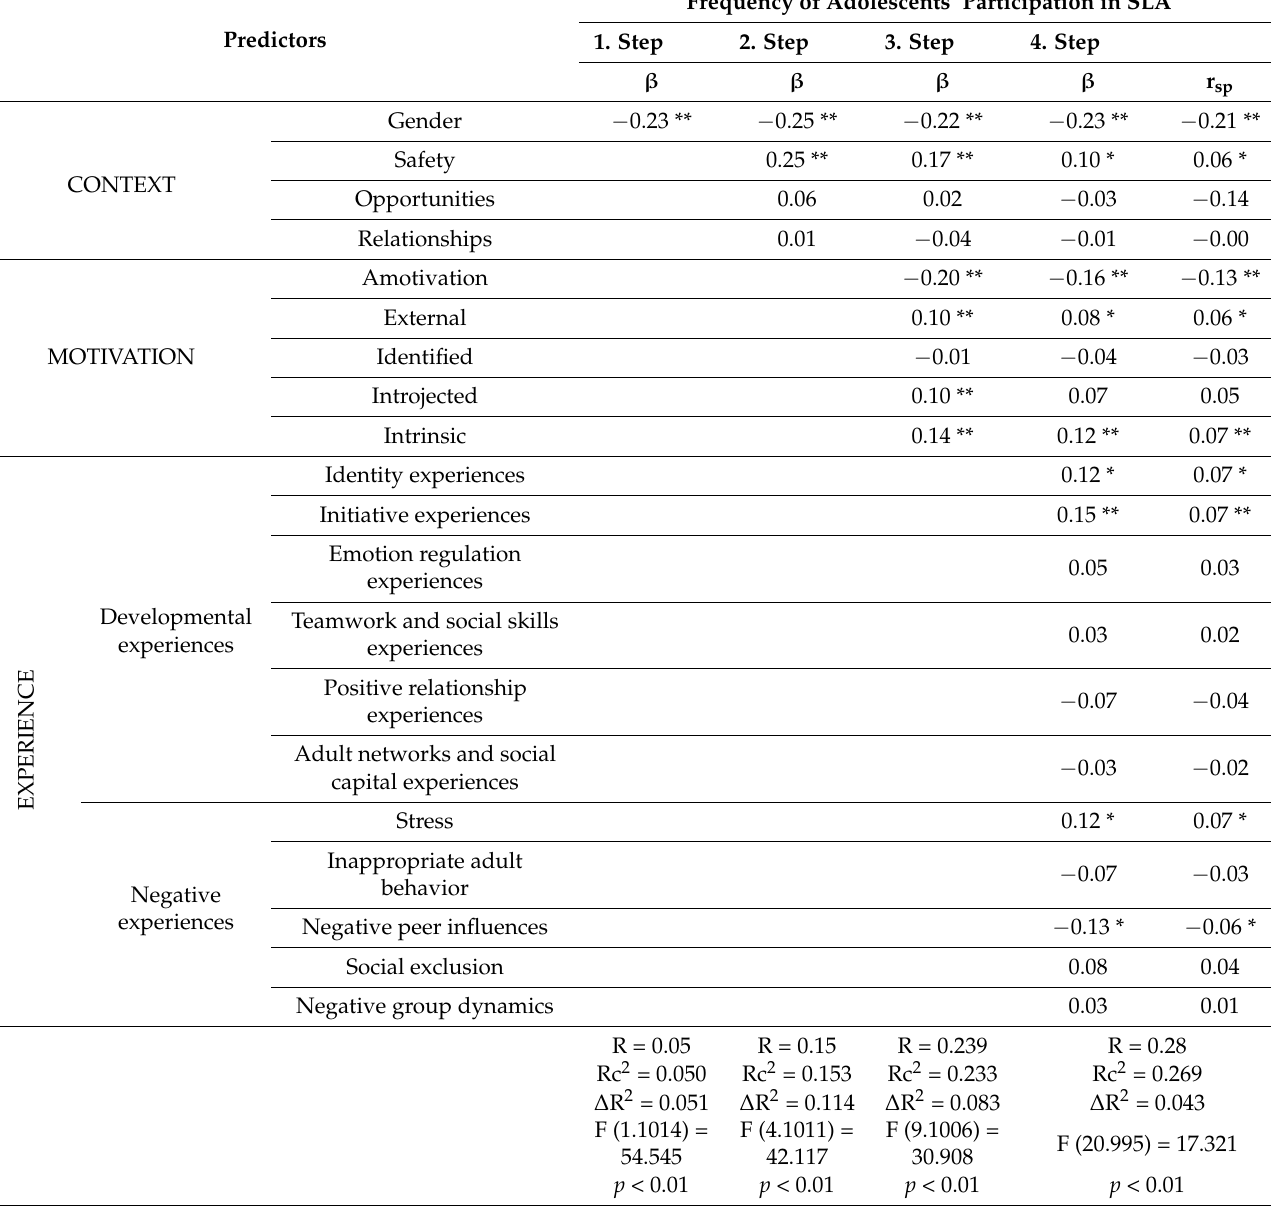
Table 4. Hierarchical regression analyses with gender, adolescents’ perceptions of context, factors of motivation, and experience of participation in SLA as predictors and the frequency of adolescents’ participation in SLA as